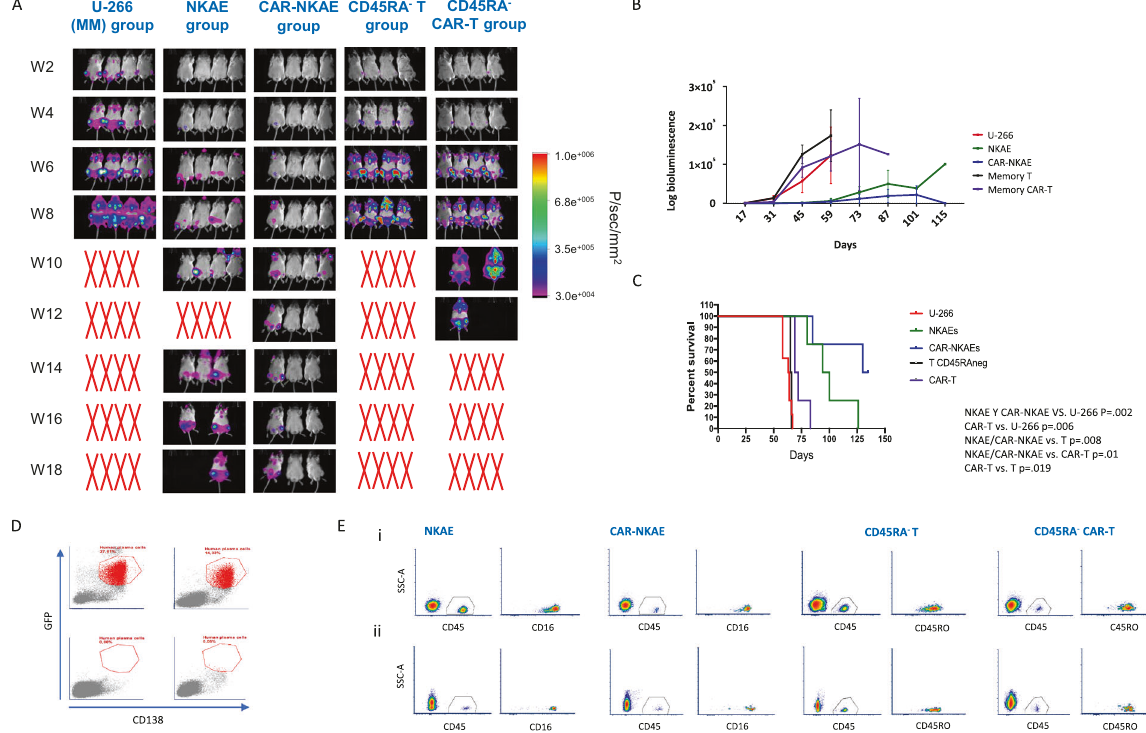
Fig. 7 NKG2D-CAR-transduced NKAE cells exhibit potent ef fi cacy in vivo. A Imaging of tumor burden monitored by bioluminescence at the indicated timepoints in MM mice, NKAE-cell-treated mice, and CAR-NKAE-cell-treated mice (At day 73 mice 2 and 3 from NKAE group were accidentally interchanged). B Quanti fi cation of the bioluminescence signal in MM mice, NKAE-cell-treated mice, CAR-NKAE-cell-treated, CD45RA − T-cell-treated mice and CD45RA − T-cell-treated mice at the indicated timepoints and C Kaplan – Meier survival curves. D Representative fl ow cytometry dotplots showing bone marrow in fi ltration (GFP + CD138 + ) of MM mice (top left), NKAE-cell-treated mice (top right), and the two CAR-NKAE-treated mice that were disease free at the end of the study (bottom). E Persistence of effector cells in peripheral